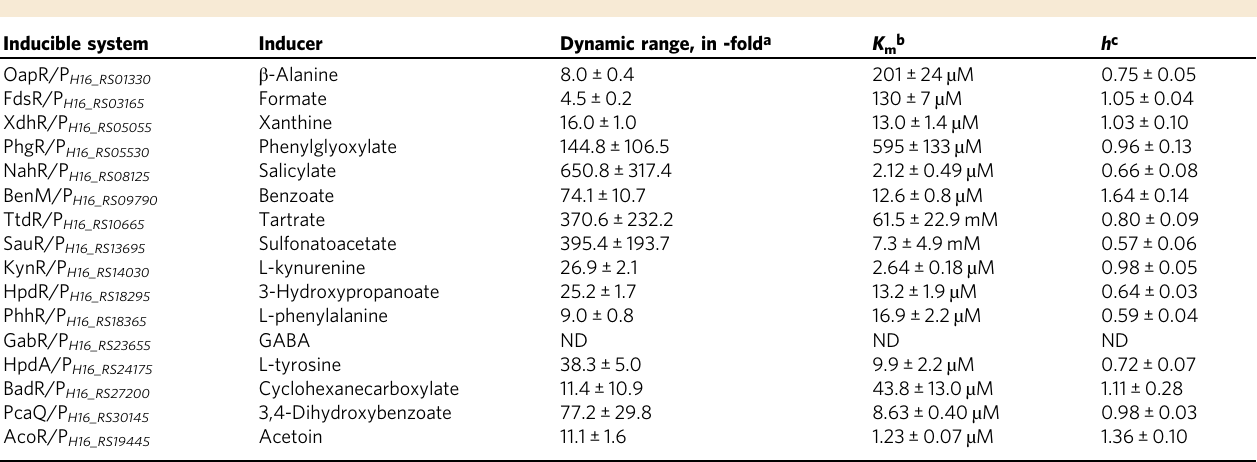
Table 1 Parameters of the native inducible systems.